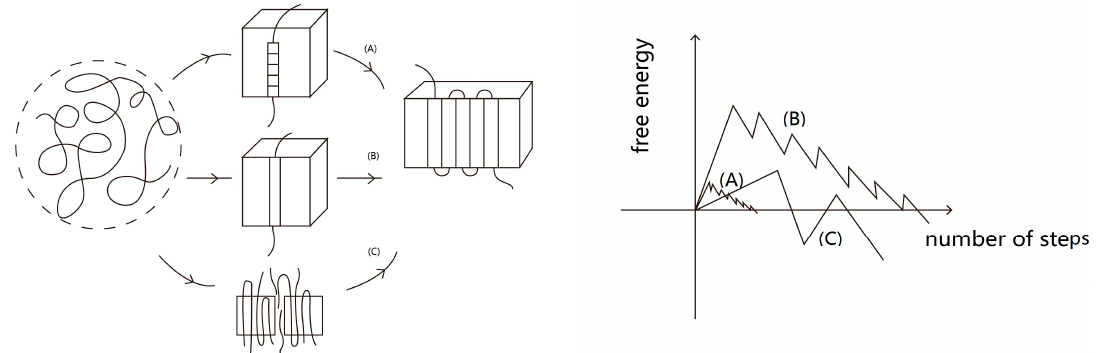
Figure 7. Schematic diagrams of three typical routes in polymer crystallization and the corresponding free energy landscapes. ( A ) Representative of fine-grained microscopic process during crystallization, either proposed by Frank and Tosi, or modified by Point, for more details, see Figure 6. The corresponding free energy diagram shows the formation of only one stem (composed of various substeps). Attachment of the first chain stem is the rate determining step. ( B ) The Hoffman–Lauritzen model, which can be regarded as a coarse-grained model compared with (A). The free energy landscape corresponding to the formation of various stems shows that initiation of the first stem is the rate determining step. ( C ) Strobl’s multistage model, in which the mesomorphic phase (which is a thermodynamic phase) is highlighted and the corresponding thermodynamic quantities different from the initial and final states can be derived. The relevant free energy landscape shows that the mesomorphic phase is a metastable phase and the rate determining step is the formation of the mesomorphic phase.